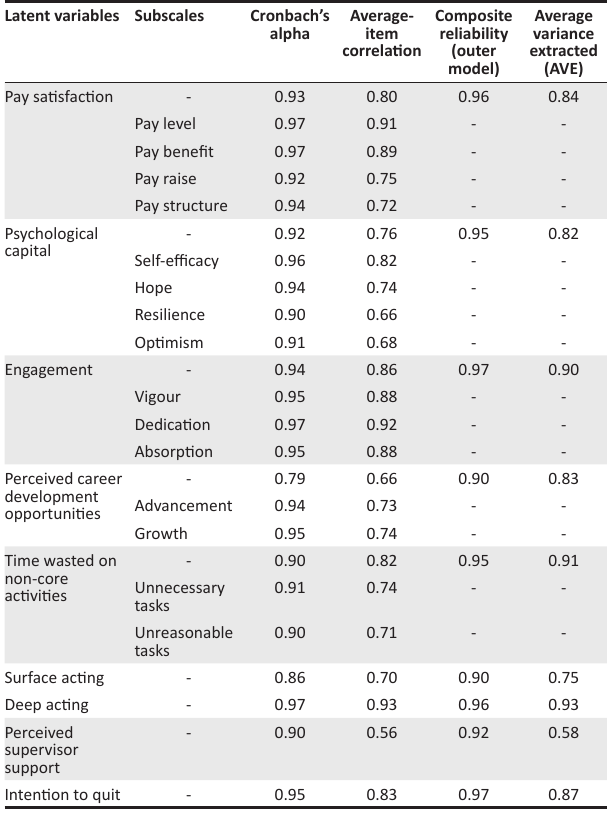
TABLE 3: Reliability and average variance extracted scores for the outer (measurement)